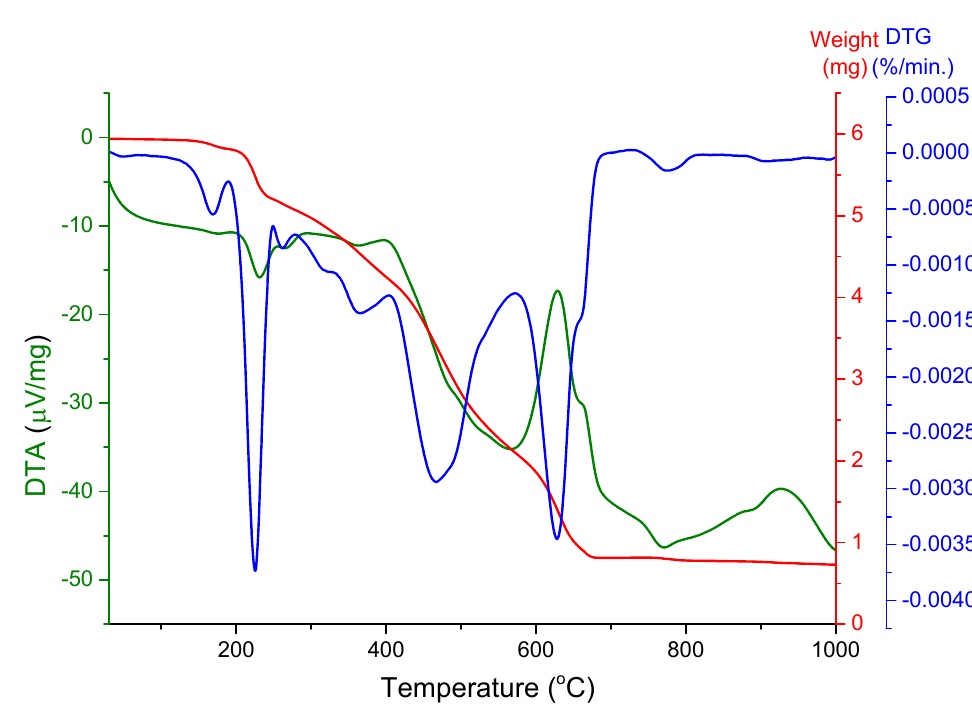
Figure 4. TGA ‐ DTG–DTA curves of [(PA) 2 ZnCl] 2 (ZnCl 4 ) ( Zn1 ). Figure 4. TGA-DTG–DTA curves of [(PA) 2 ZnCl] 2 (ZnCl 4 ) ( Zn1